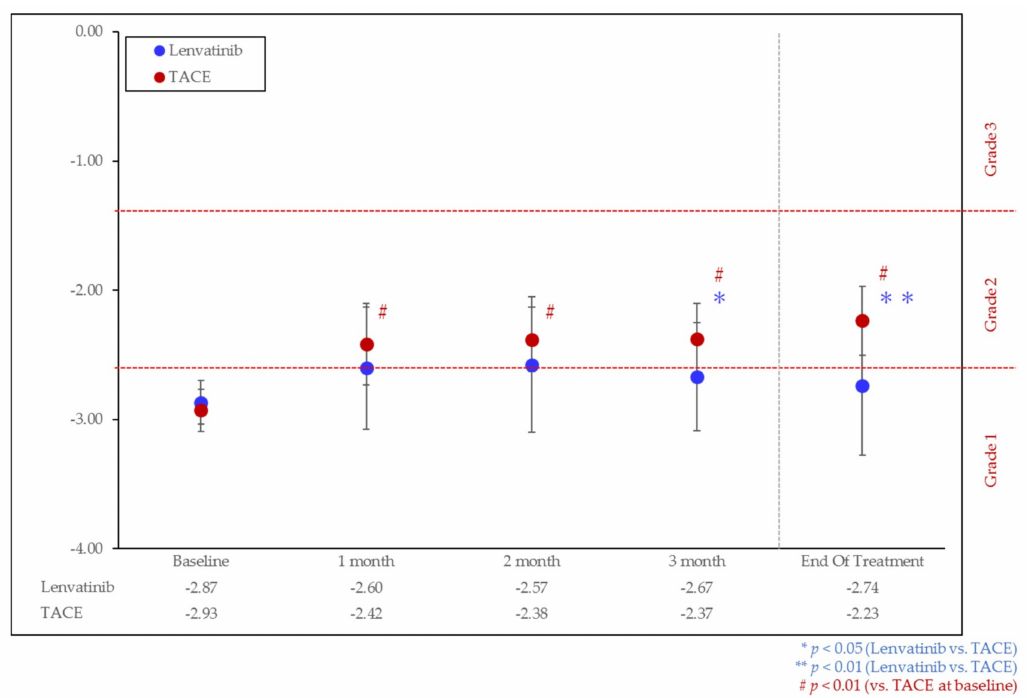
Figure A1. Albumin-bilirubin (ALBI) score over time in patients with ALBI grade 1 treated by lenvatinib ( n = 19) or TACE ( n = 37) (propensity score matching results). ALBI score was significantly worsened at the end of treatment ( − 2.23) as compared with that at the baseline ( − 2.93) in TACE treated group ( p < 0.01). In contrast, ALBI score was maintained at the baseline ( − 2.87) and at the end of treatment ( − 2.74) in the lenvatinib-treated group.